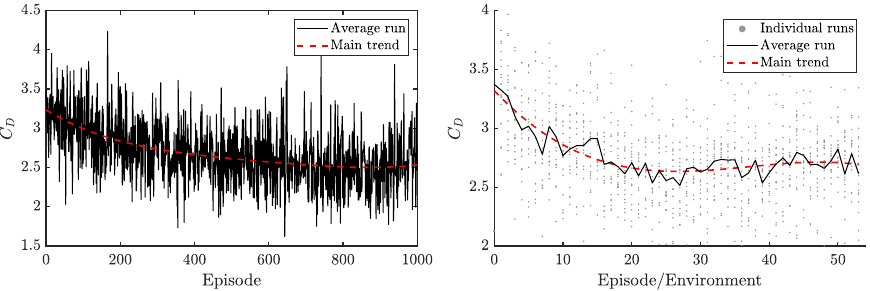
Figure 11. Evolution of C D in the last vortex-shedding for each episode employing a single environ- ment ( left ) or a 20-multi-environment approach ( right ) showing the learning curve indexed by the episode number for one of the 20